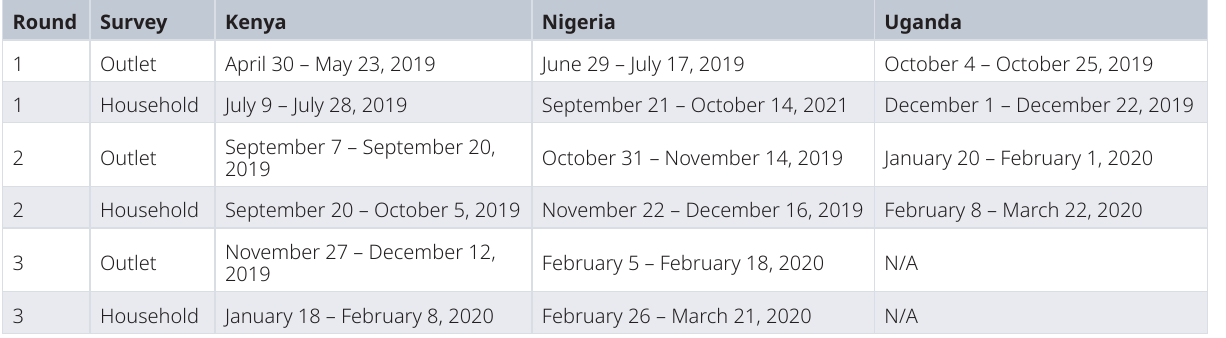
Table 2. Dates of data collection by round and study site. Round